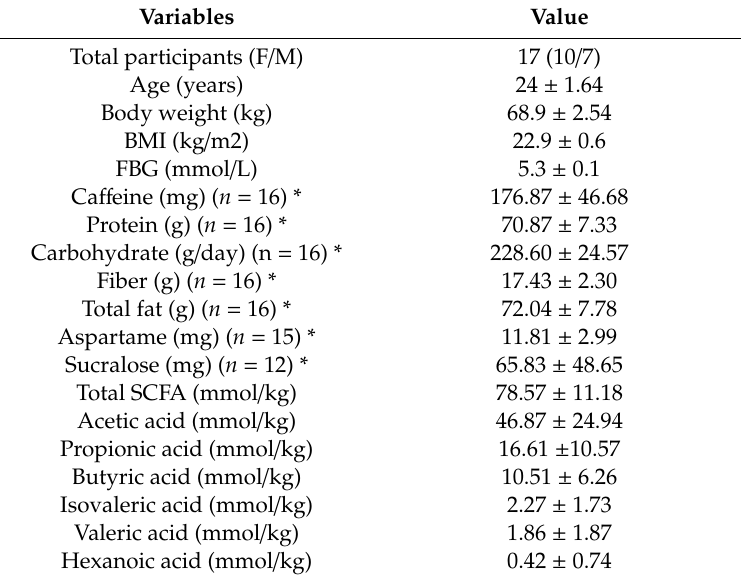
Table 2. Characteristics of participants at baseline 1